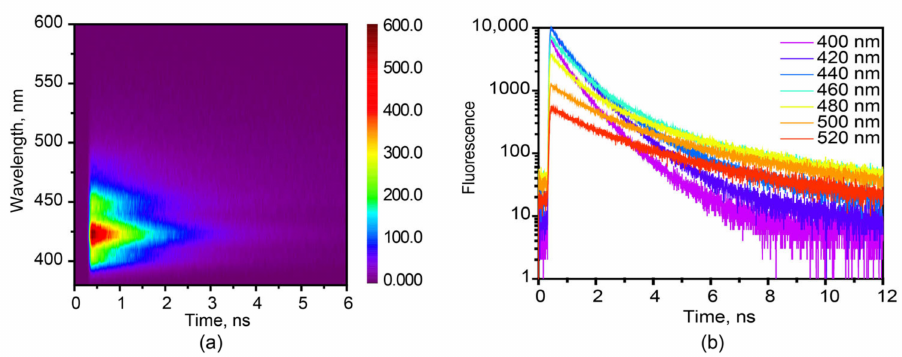
Figure 2. ( a ) Fluorescence TCSPC map of the hexaphenyl film, λ exc = 360 nm. ( b ) Fluorescence kinetics of hexaphenyl film at various probe wavelengths, λ exc = 360